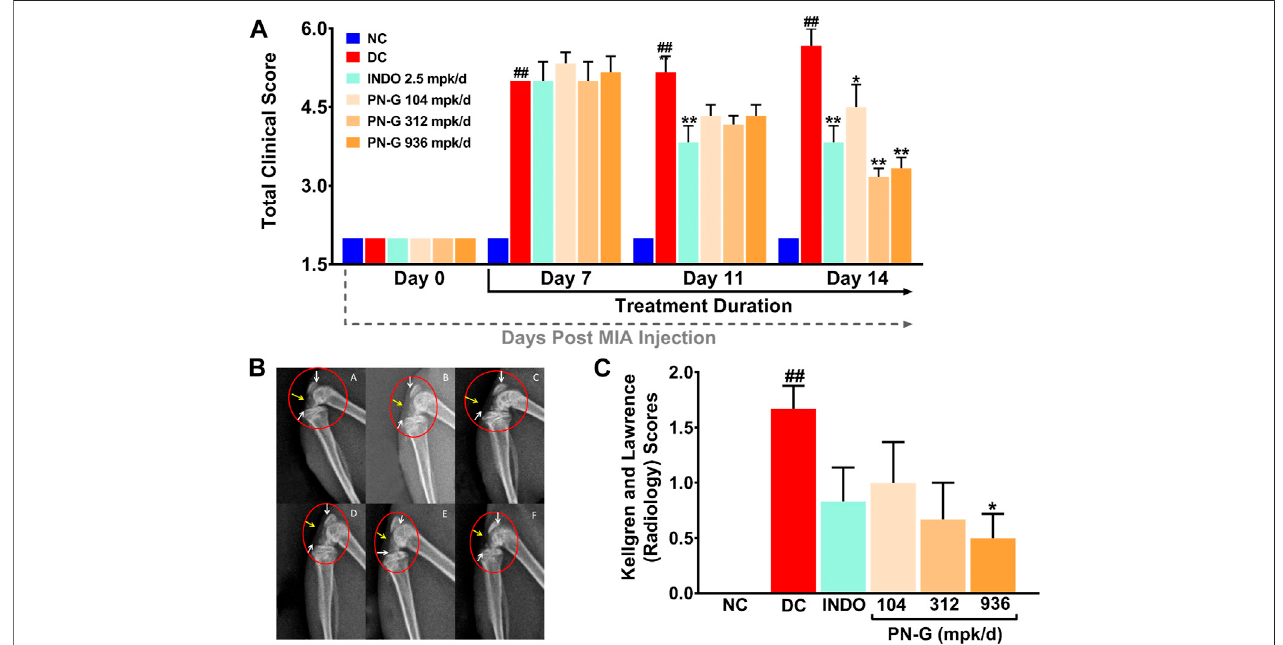
FIGURE 4 | PN-G exhibited clinical abrogation of osteoarthritis. (A) Bar graph showing the effect of PN-G treatment on osteoarthritic clinical scores determined from joint swelling and limping. (B) Representative radiograms of right knee joints of rats belonging to different experimental groups, namely, NC (A) , DC (B) , INDO (C) , PN-G 104 (D) , PN-G 312 (E) and PN-G 936 (F) depicting various radiological features, like, joint space & radiodensity (yellow arrow) and surfaces of femoral condyles and proximal tibia (white arrow). (C) Bar graph showing the effect of PN-G treatment on the Kellgren and Lawrence scores, that depict the extent of osteoarthritic severity.Dataisrepresentedasmean±SEM( n =6animalspergroup)andwasstatisticallyanalyzedusingtwo-wayANOVAfollowedbyTukey ’ smultiplecomparison. ## indicates signi fi cant difference with respect to NC ( p < 0.01) whereas * and ** depict a statistically signi fi cant effect when compared to DC (* p < 0.05 and ** p <